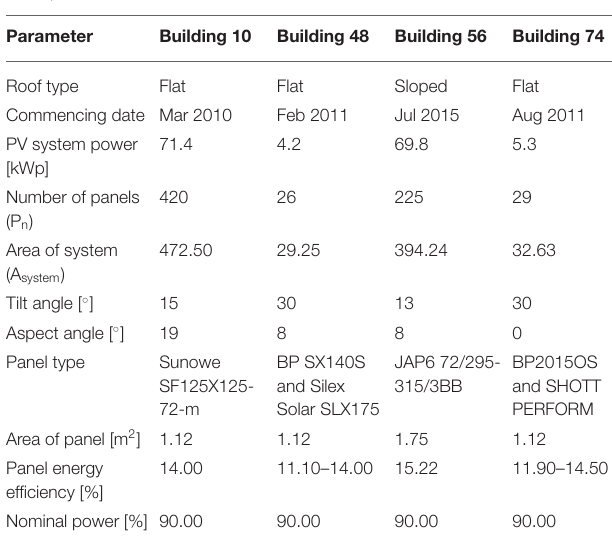
TABLE 3 | Summary information for solar PV systems mounted at four building